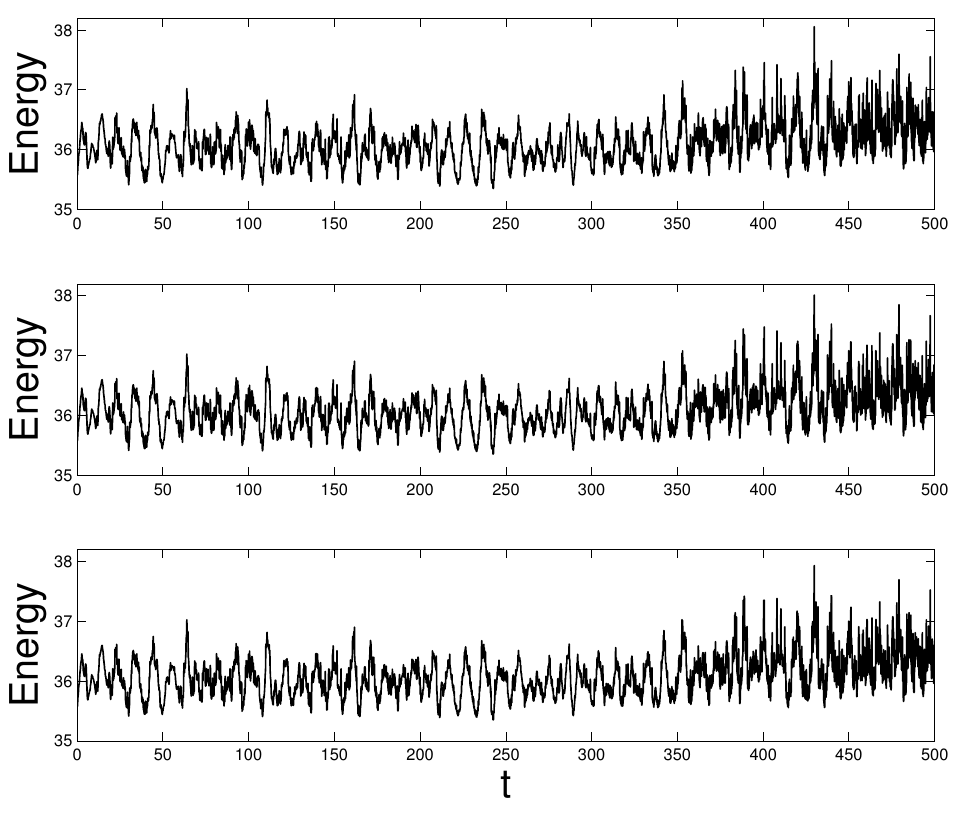
Figure 14. The discrete energy E N for the control-theoretic strategy: Integration in time was performed with the 4th-order Gauss ( top ), 4th-order Lobatto IIIA–IIIB ( middle ), and non-symplectic 5th-order Radau IIA ( bottom )